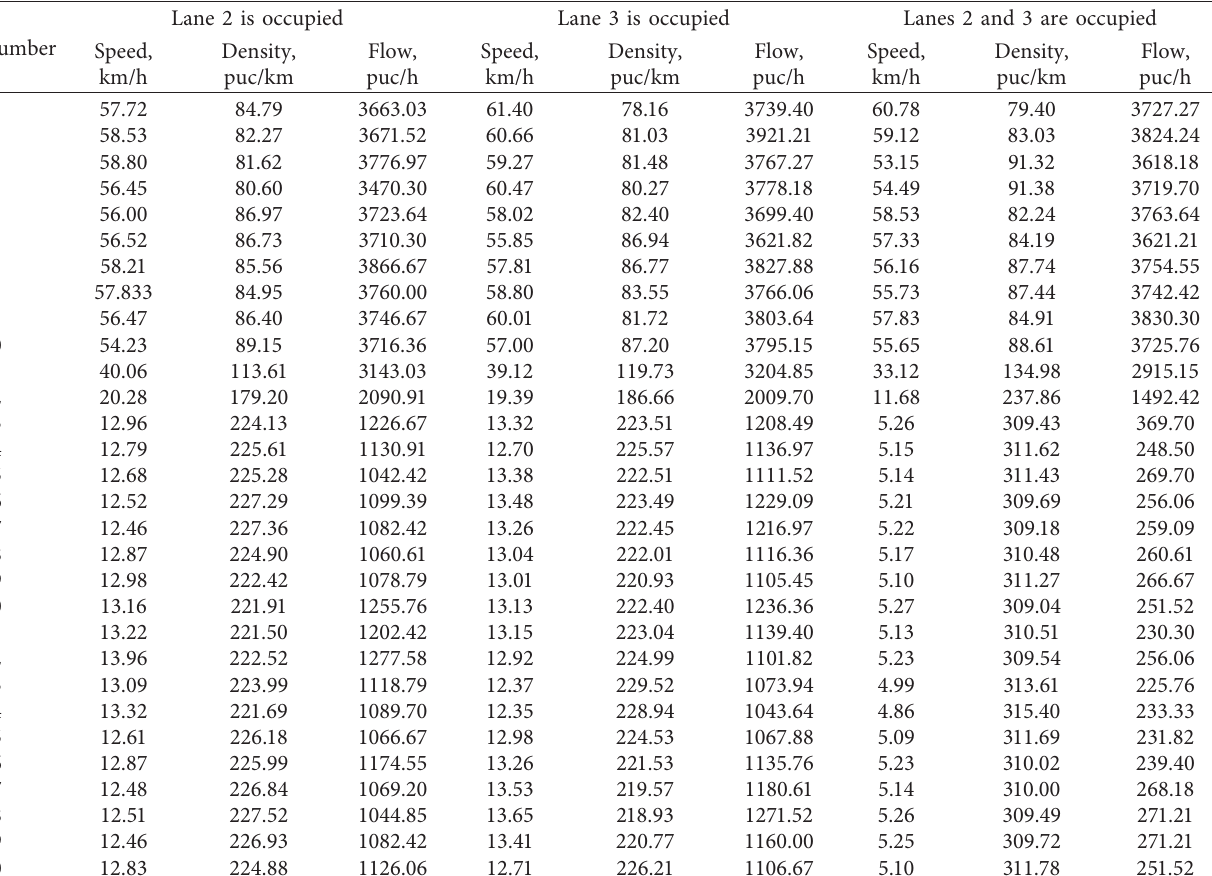
Table 1: Traffic flow simulation data under occasional accidents.